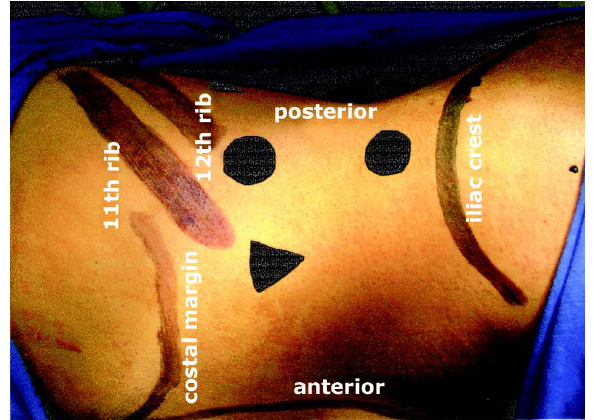
Figure 7 – Positioning of the ports for surgery in the lumbar region (patient in left lateral decubitus). = 5 mm port; = 10 mm